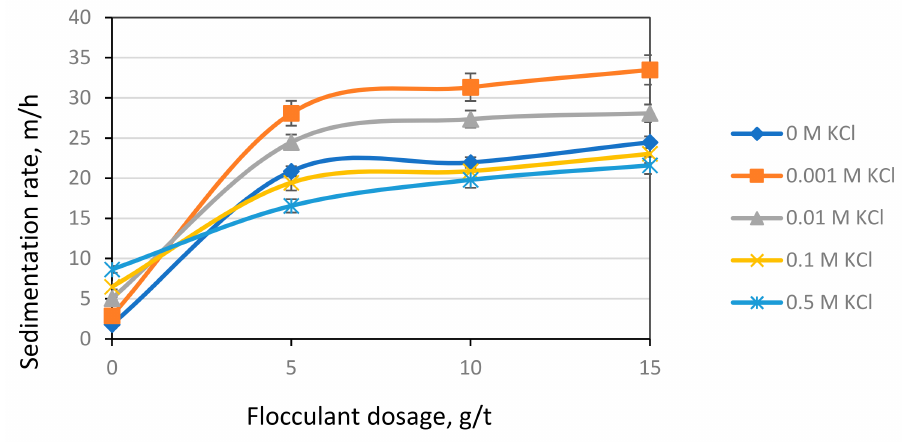
Figure 5. Sedimentation rate relative to Magnafloc-1011 flocculant dose in deionized water.